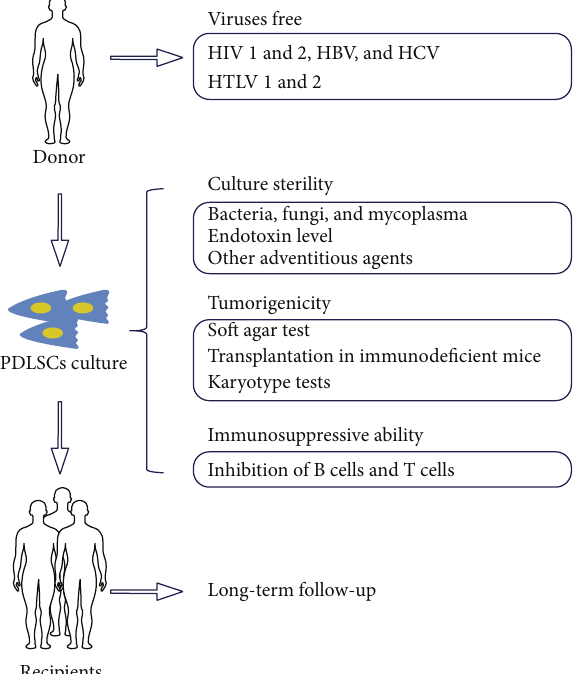
Figure 3: Biological safety during application of periodontal ligament stem cells. Donors must be free of viral infection to prevent cross infection between donor and recipient. Also, contamination by pathogenic microorganisms and adventitious agents during culture should be excluded. Next, the risk of tumor formation must be evaluated before PDLSC transplantation. Also, immunosuppressive ability should be tested to ensure the safety of allogeneic PDLSC transplantation. Finally, long-term follow-up of recipients is necessary to study the fate of PDLSCs and to minimize future risks after